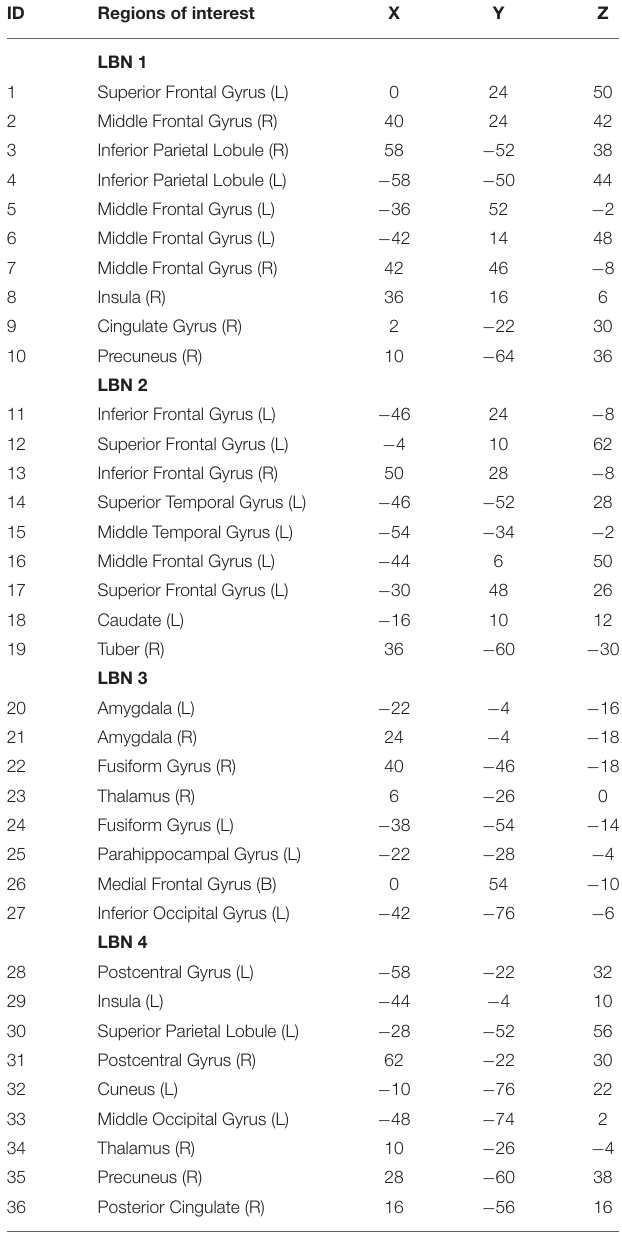
TABLE 1 | The MNI coordinates of the ROIs within four large-scale brain networks enrolled in emotion regulation. ID Regions of